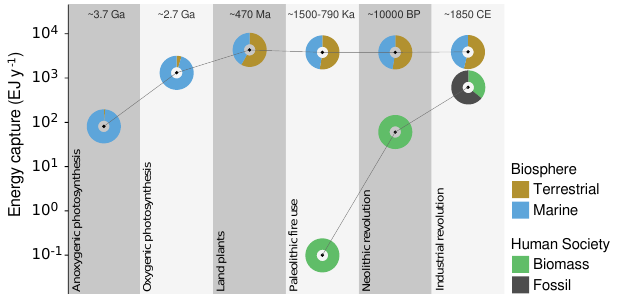
Figure 1. Energy capture in the biosphere and human society. Dates indicate beginning of the respective revolution, energy estimates are given for dates where energy regimes had matured. Data and sources are in Table